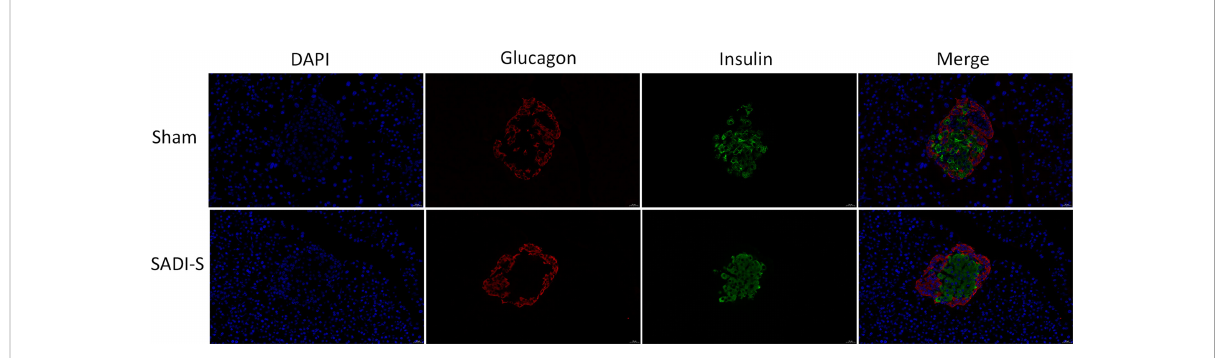
FIGURE 2 Immuno fl uorescence double-labeling staining images. Morphological and histological evaluation of pancreas tissues between the SADI-S group and the sham operation group. Red represents pancreatic islet a cells, green represents pancreatic islet b cells, and blue represents cell